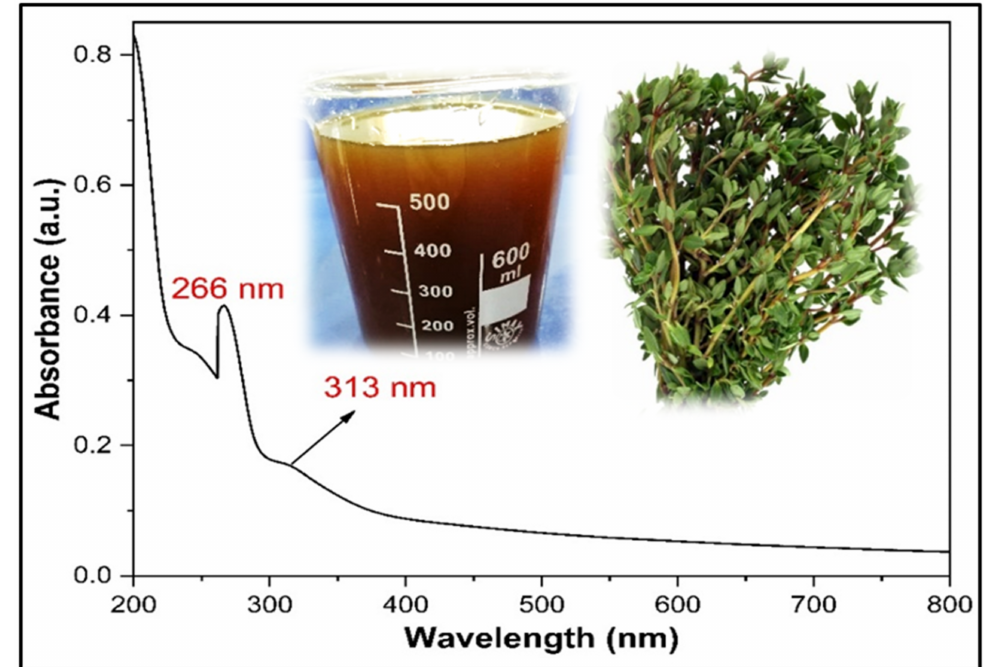
Figure 3. The UV–visible spectrum of leaf extracts of thyme